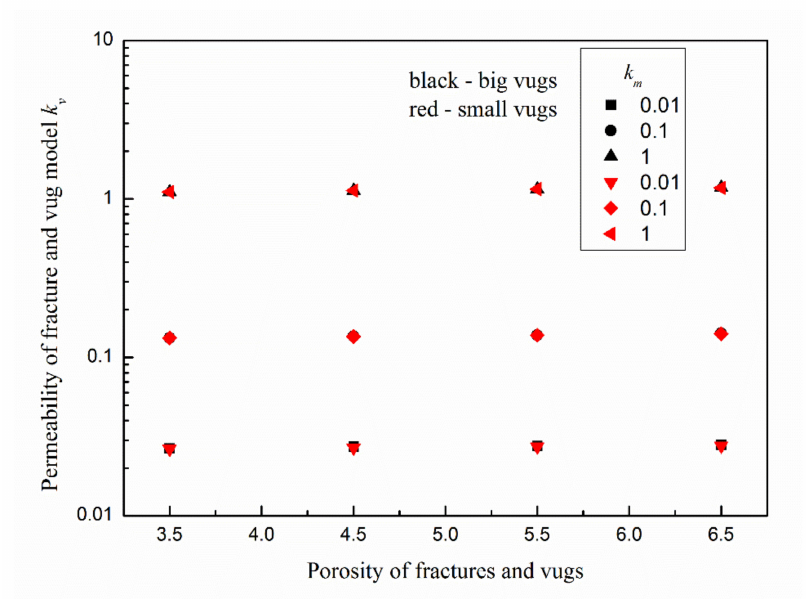
Figure 11. Comparison between big vugs and small vugs.